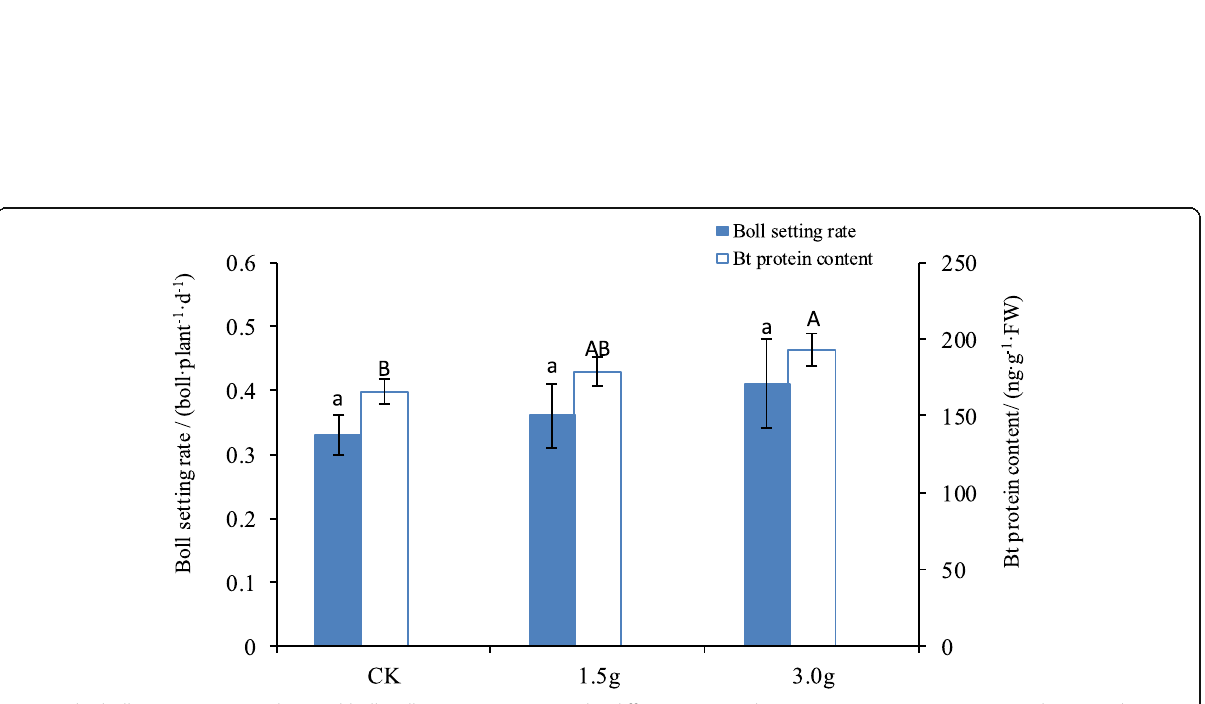
Fig. 8 The boll setting rate per plant and boll wall Bt toxin content under different DPC applications treatments in 2018. Sympol 1.5 g and 3.0 g represented the application rate of DPC during the peak flowering stage respectively, CK was the control. The vertical bar represents S.E. of the mean ( n = 3) when the value exceeds the size of the symbol. Lowercase letters indicate significance analysis among boll setting rate per plant, and capital letters indicate significance analysis among Bt protein content. The same letter among treatments is not significantly different ( P ≥